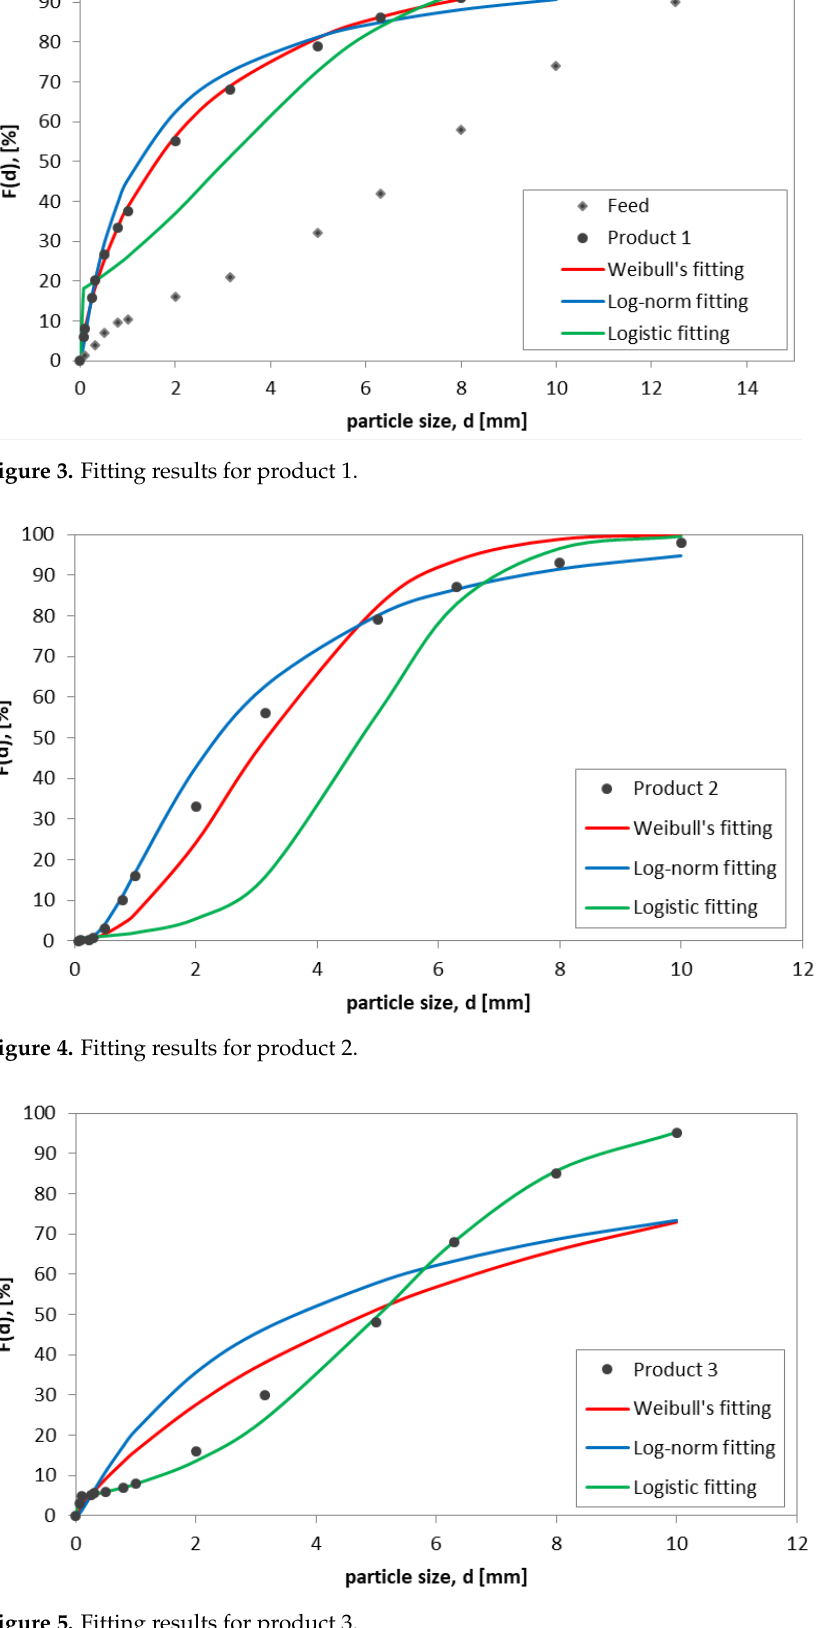
Figure 5. Fitting results for product 3.